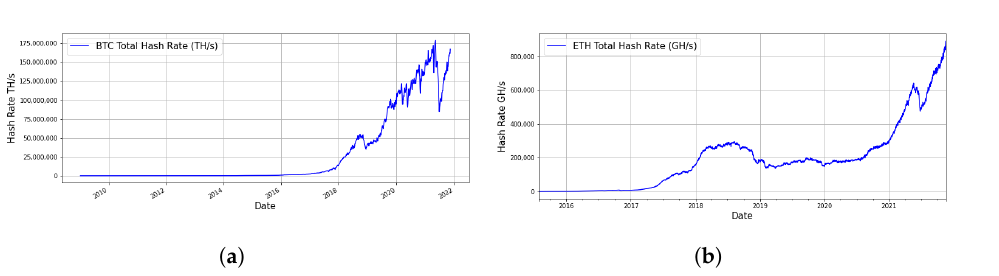
Figure 4. Total Hash Rate. ( a ) Bitcoin (TH/s) (source: blockchain.com, accessed on 18 November 2021). ( b ) Ethereum (GH/s) (source: etherscan.io, accessed on 18 November 2021).